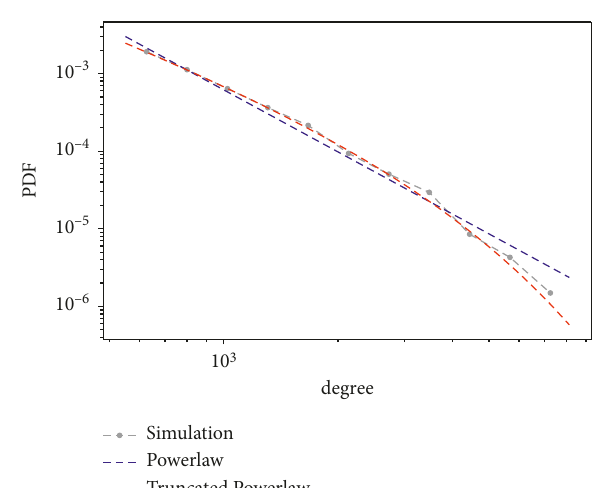
Figure 9: Number of edges versus number of nodes in log-log scales.